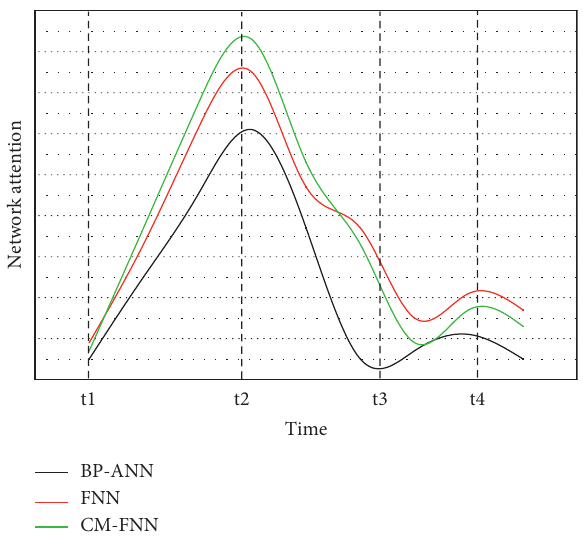
Figure 6: Ice and snow tourism network attention foreshadowing effect curve.